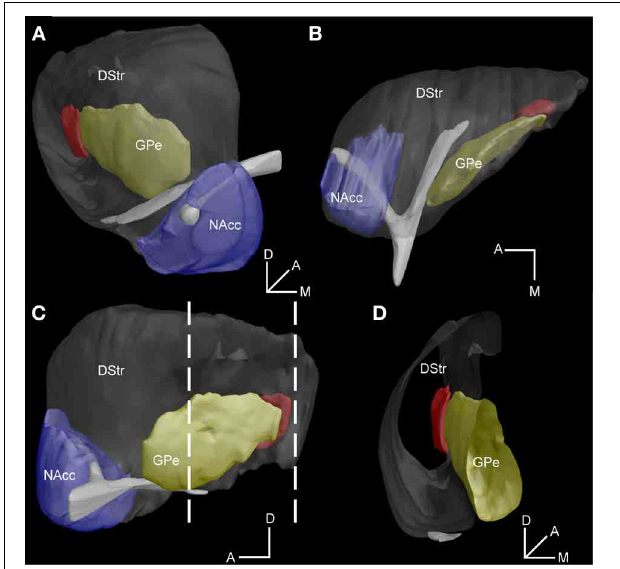
FIGURE 5 | 3D reconstruction model of the D2R-expressing MSNs-poor zone of the caudal striatum. (A–C) Illustration of the striatum within the global model as examined from frontal (A) , parahorizontal (B) and sagittal (C) views of the model. (D) Virtual coronal slice of the striatum at the level indicated by the stippled lines in C . The DStr, dorsal striatum in gray, NAcc, nucleus accumbens in blue, GPe, external globus pallidus in yellow and the area lacking striatopallidal D2R/A2aR MSNs in red. Orientation axes: D, dorsal, A, anterior, M,